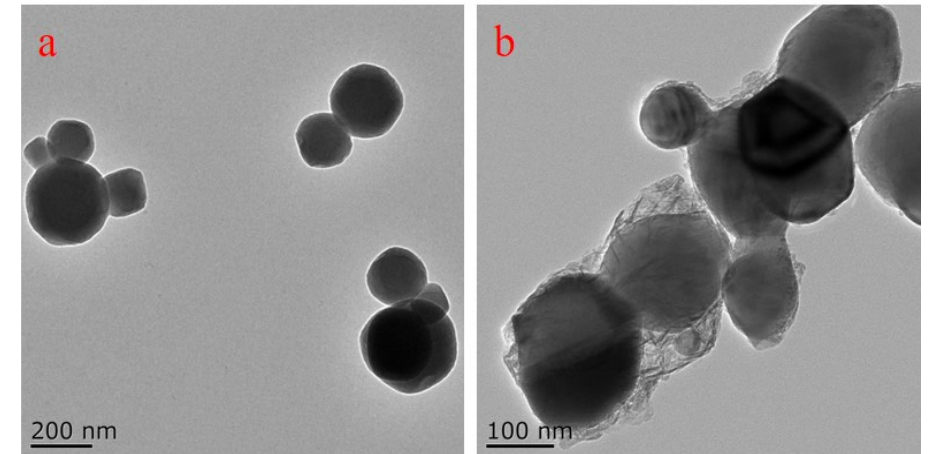
Figure 1. Typical TEM images of titania pigment ( a ) and OTP ( b ).